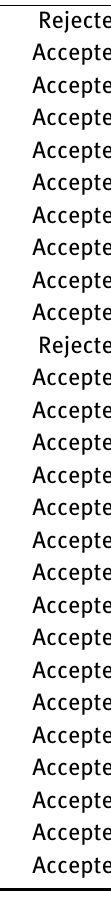
Table 6: p-value and VIF of formative indicator